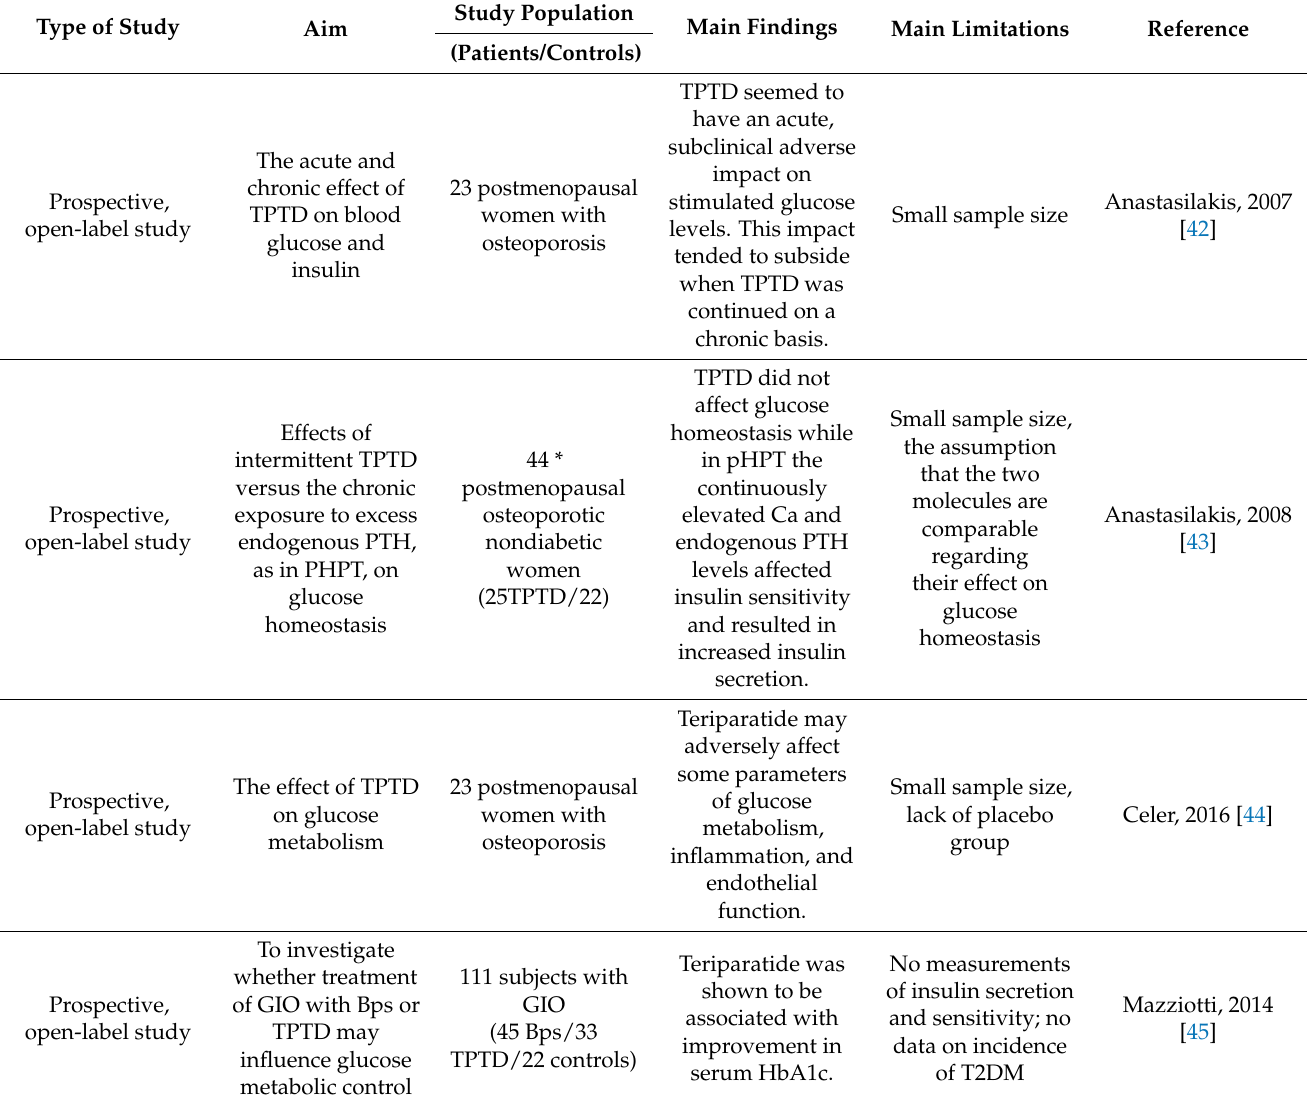
Table 1. Clinical studies focused on the effect of antiosteoporotic agents on glucose